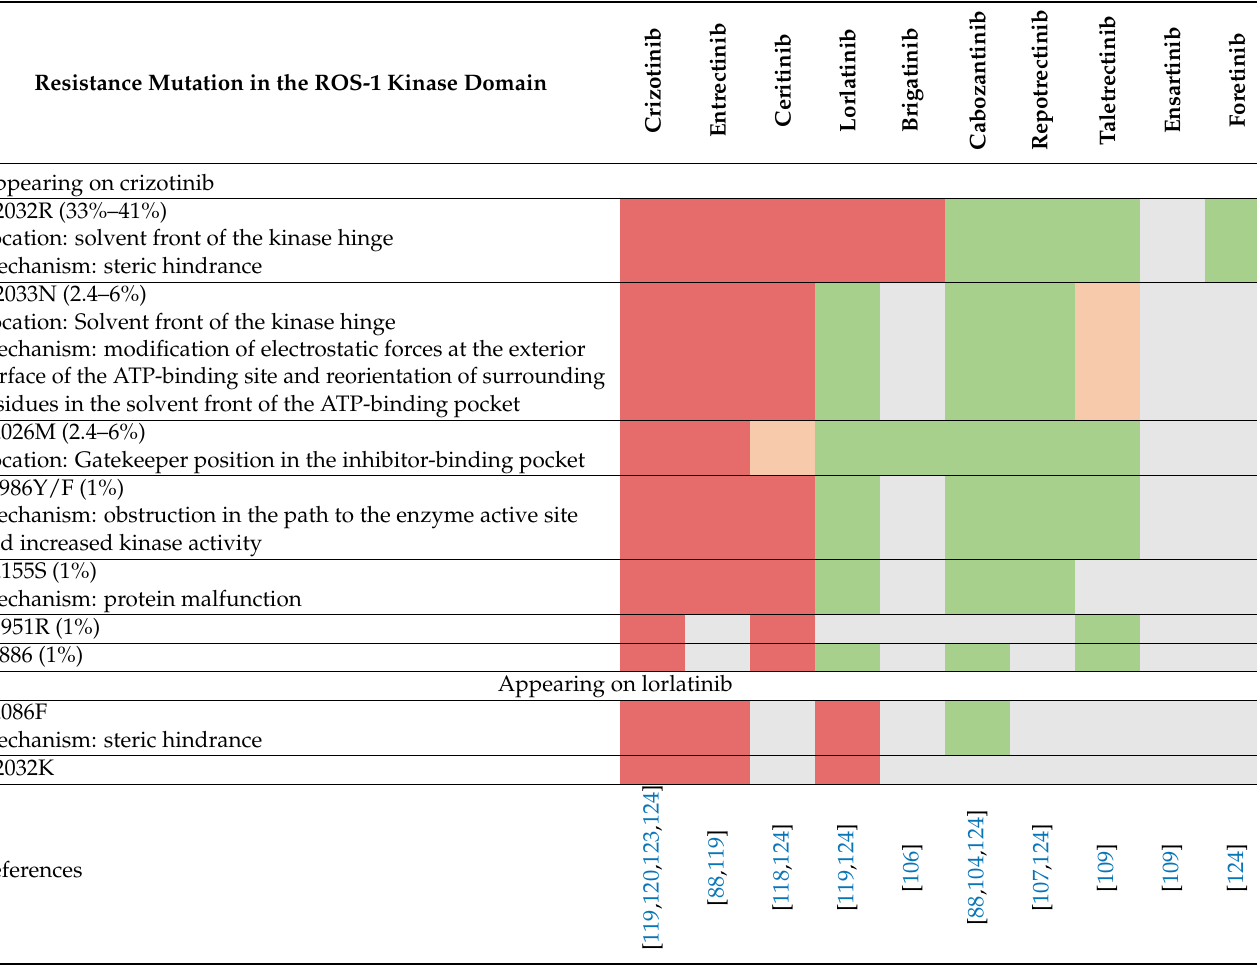
Table 3. Sensitivities of resistance mutations appearing in the ROS-1 kinase domain to the different tyrosine-kinase inhibitors. (red: No anti-tumor activity (in vitro and/or clinical); orange: In vitro anti-tumor activity only at high concentration; green: Anti-tumor activity (in vitro and/or clinical)